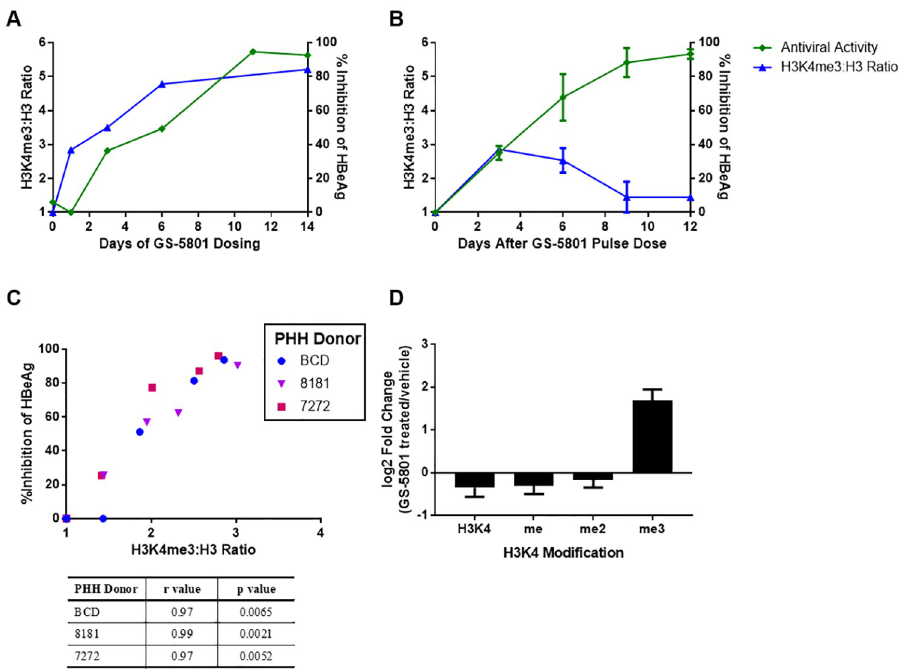
Fig 5. GS-5801 causes global increases in H3K4me3:H3 that precede antiviral activity. PHH were infected with HBV for three days prior to initiation of GS-5801 treatment. (A) PHH were treated with vehicle or 10 μ M GS-5801 every three to four days for a total of 14 days (continuous dosing). Data shown are from donor 8130 and are representative of data from continuous dosing experiments. (B) PHH were treated with vehicle or 10 μ M GS-5801 once for two hours with vehicle or 10 μ M GS-5801 prior to replacing medium with fresh medium without drug or vehicle (pulse dosing). Note that the half-life of active parent of GS-5801 in hepatocytes is 42–66 hrs leading to sustained exposure during the 3 day periods. Data shown are the average values from three PHH donors (BCD, 8181, 7272) and error bars represent the standard deviation. (A, B) At the timepoints shown, levels of secreted HBeAg were measured by immunoassay and are plotted as the percentage inhibition of HBeAg in GS-5801 treated PHH relative to vehicle treated PHH. In addition, levels of H3K4me3 relative to H3 (H3K4me3:H3) were measured by ELISA in vehicle and GS-5801 treated PHH and are plotted as the ratio of H3K4me3:H3 measured in GS-5801 treated PHH relative to vehicle treated PHH. (C) The relationship of H3K4me3:H3 ratio increases to HBeAg inhibition in PHH (donors BCD, 8181, 7272) treated with a single two hour pulse dose of 0.1, 1, 3, or 10 μ M GS-5801 relative to vehicle- treated PHH are shown. The H3K4me3:H3 ratio of GS-5801 treated cells was normalized to vehicle treated cells at day three after a two hour pulse dose. The percentage inhibition of HBeAg was measured at the end of the experiment (day 12 or 14 post-initiation of dosing) and plotted as the inhibition of HBeAg in GS-5801 treated PHH relative to vehicle treated PHH. (D) Uninfected PHH cells treated with vehicle or 10 μ M GS-5801 every 3 days. On Day 7 (24 hours after last GS-5801 dose) histones were purified and levels of H3K4 (unmodified), H3K4me1 (methylated), H3K4me2 (di- methylated), and H3K4me3 (trimethylated) TKQTAK peptides were measured by mass spectrometry. Data shown are the average ratios of unmodified, methyl, dimethyl, and trimethyl H3K4 peptide TKQTAR (log2 (GS-5801 treated/ vehicle)) measured from three biological replicates. Error bars represent standard